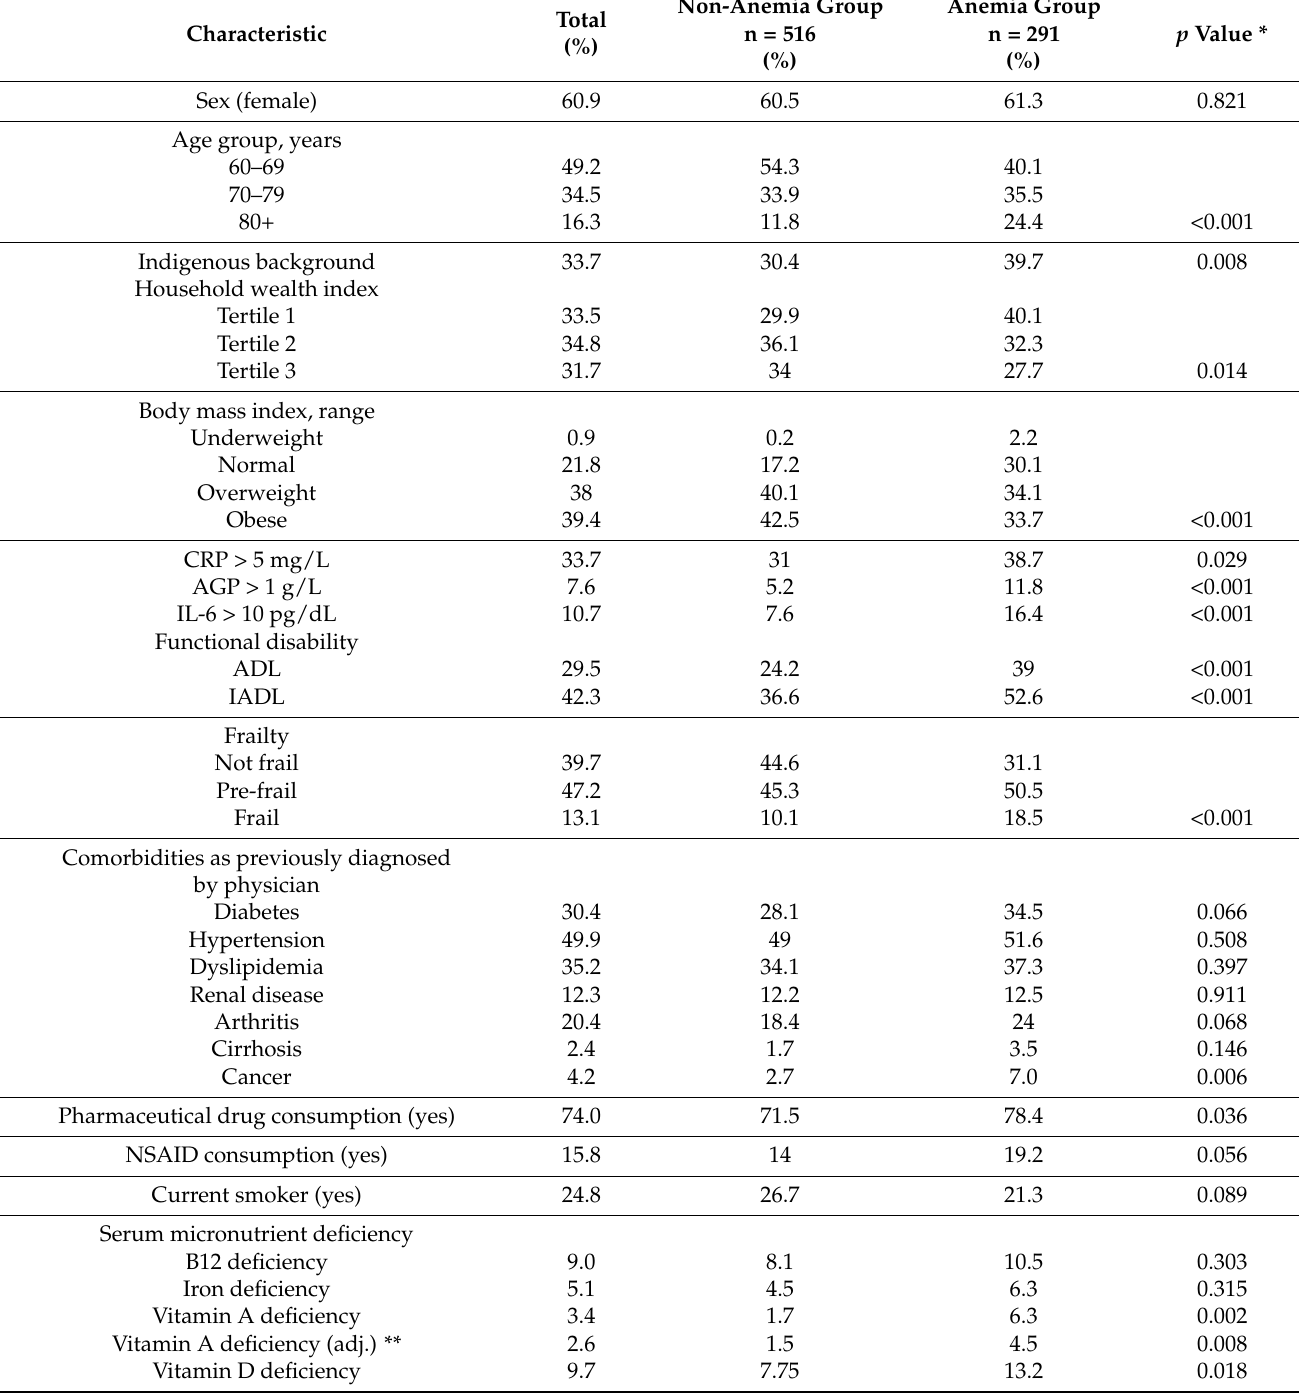
Table 1. Descriptive characteristics of older adult study population by anemia